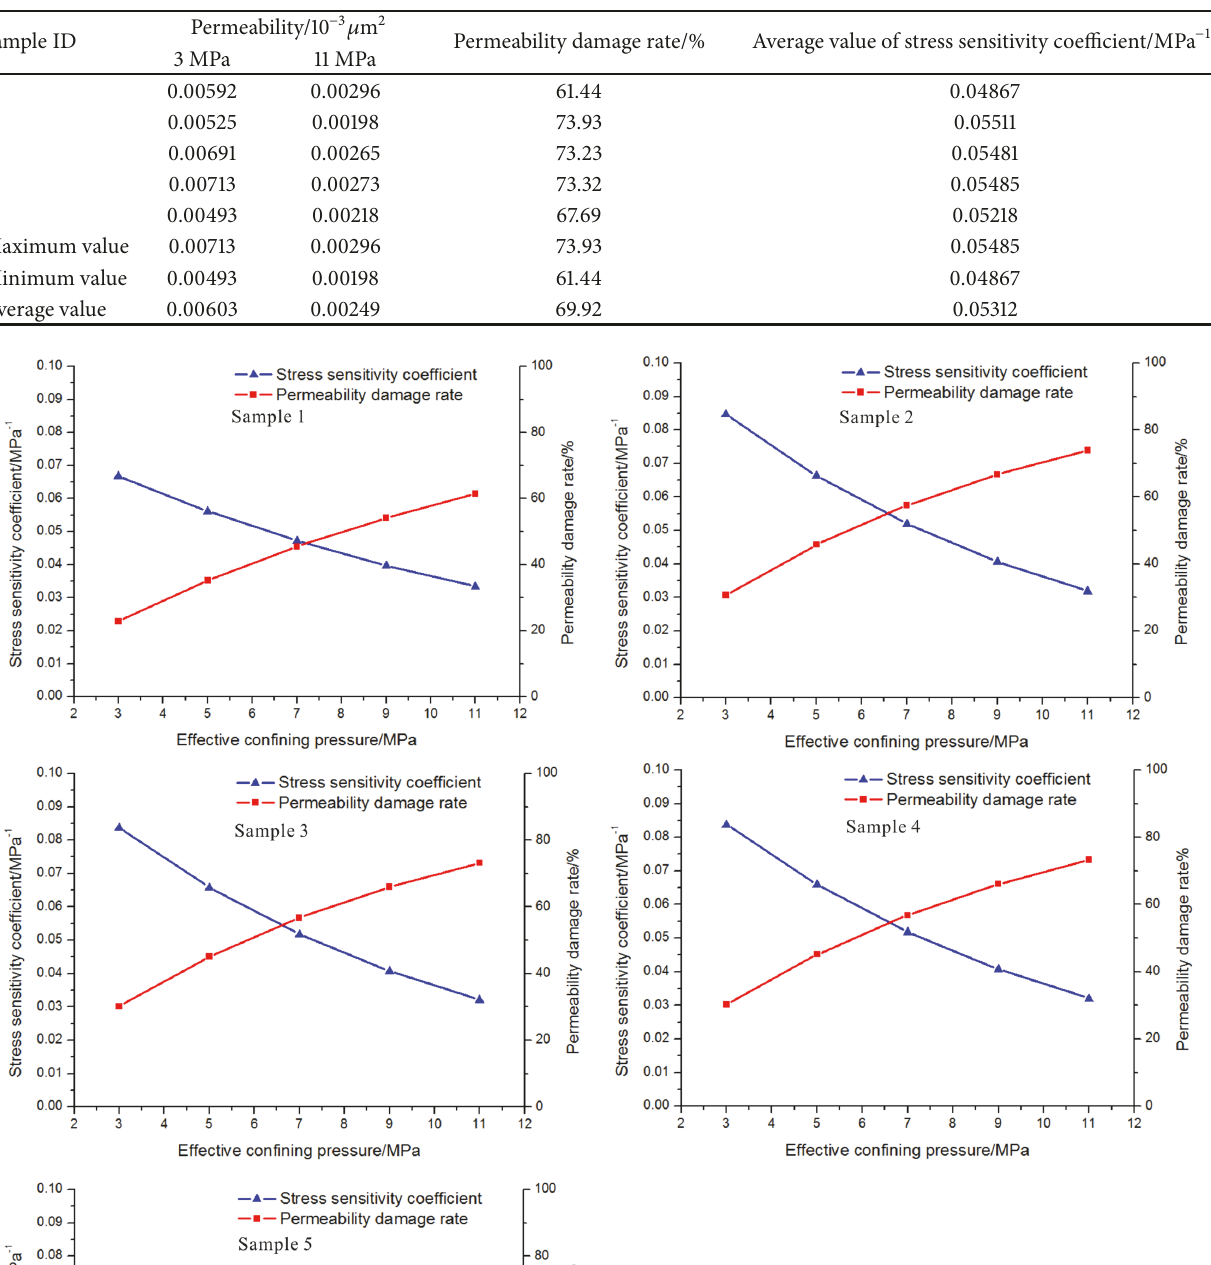
Table 3: Evaluation parameters of stress sensitivity for the shale reservoir.